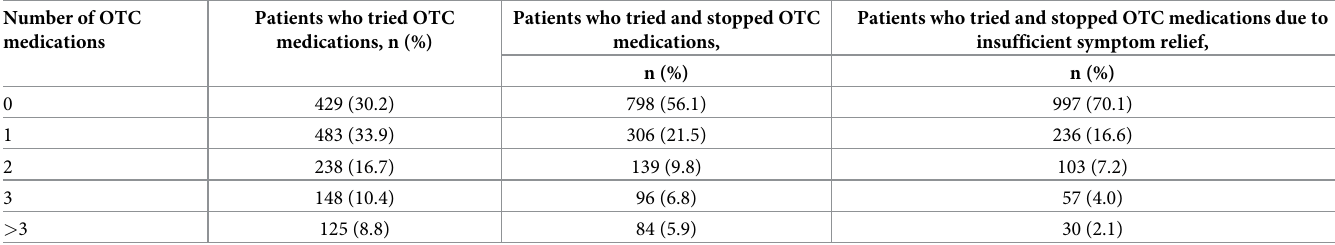
Table 2. Number of OTC medications patients tried during the previous 6 months (N = 1423). Number of OTC medications